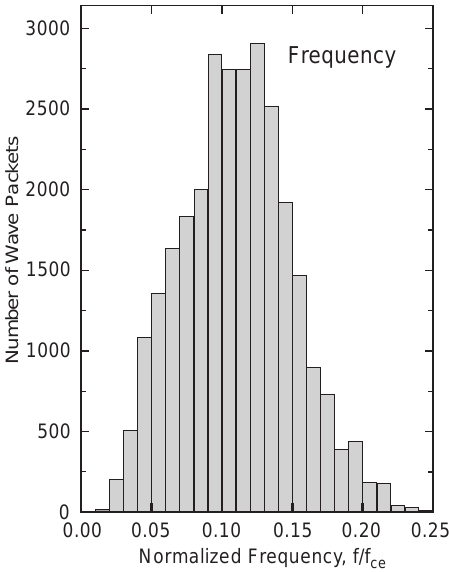
Fig. 5. Occurrence distribution of normalized lion roar frequencies